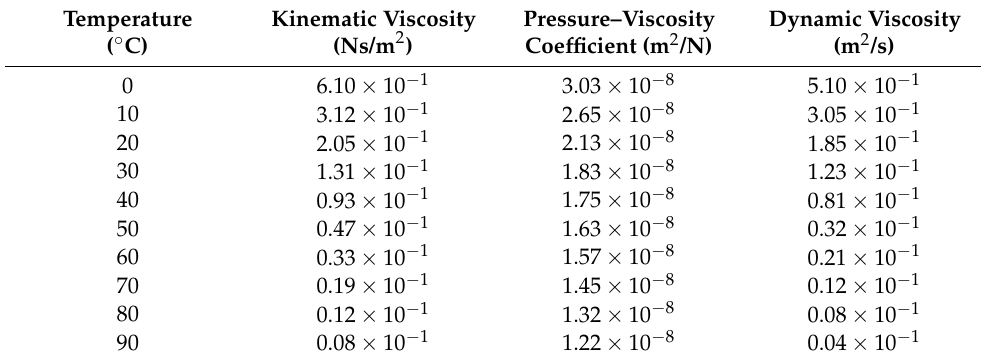
Table 3. Lubricating oil parameters after affected by temperature.